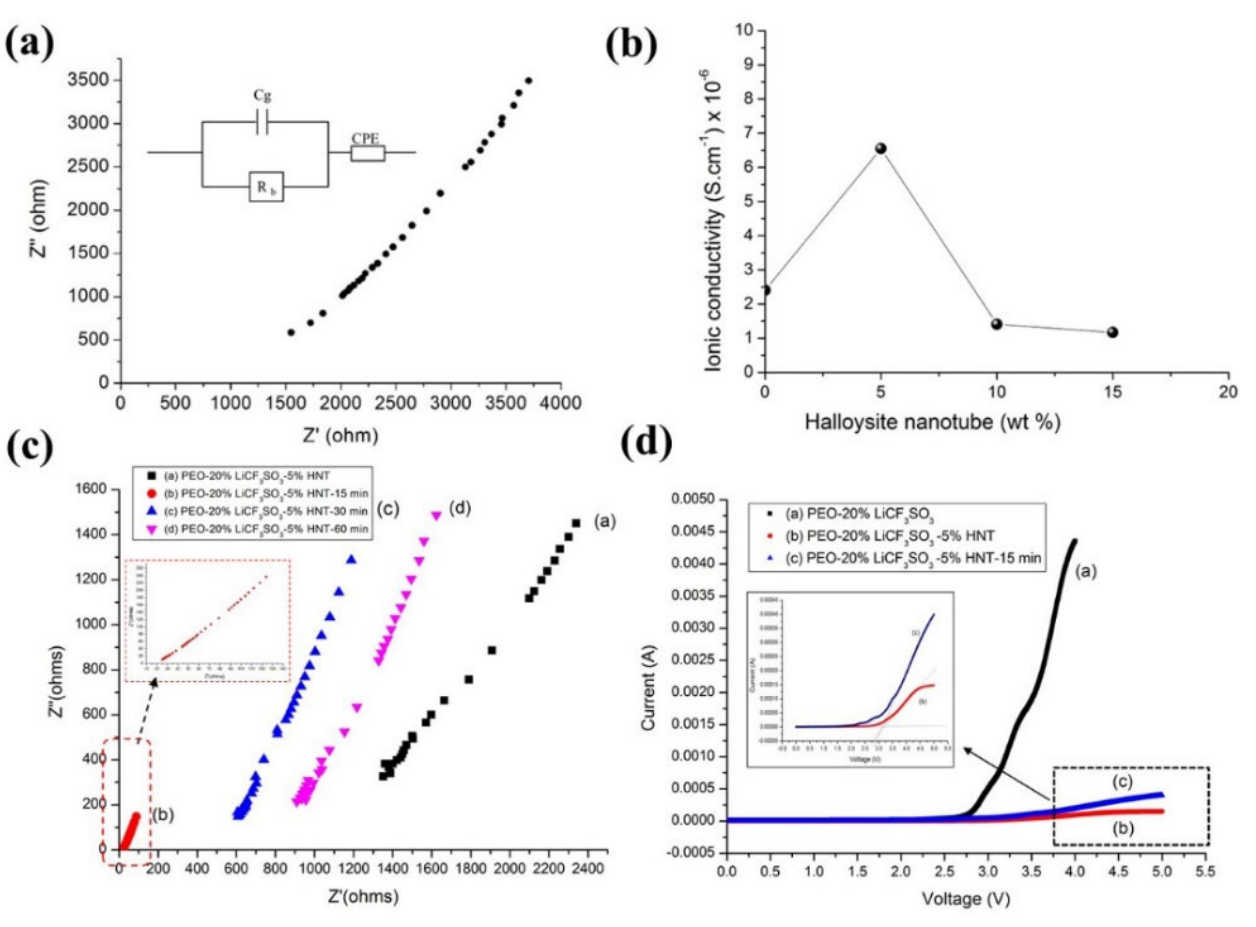
Figure 9. ( a ) Nyquist plot for Non − US of PEO − 20%LiCF 3 SO 3 at room temperature, ( b ) the ionic con ‐ ductivity for Non US of PEO 20%LiCF 3 SO 3 y%HNT, ( c ) Nyquist plot of PEO 20%LiCF 3 SO 3 5%HNT with various ultrasonic exposure time and ( d ) Linear sweep voltam ‐ mogram. Table 3. The ionic conductivity at room temperature of solid polymer electrolytes. Solid Polymer Electrolytes Ultrasonication Time ( min ) Ionic Conductivity ( S/cm )